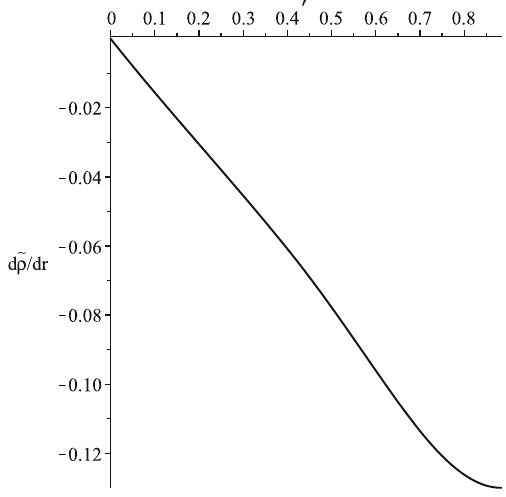
Fig. 4 Gradient of the energy density for the solution obtained with the first algorithm with F = 0 from the isotropic Gold III